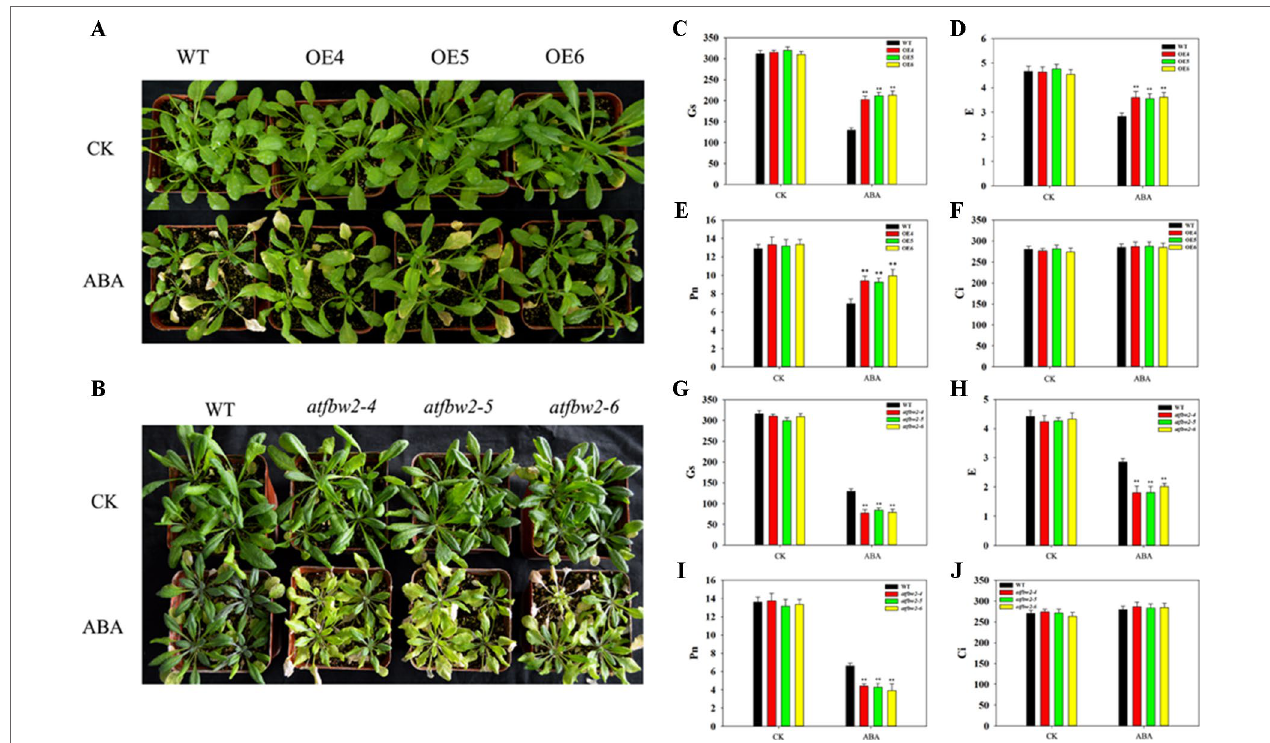
FIGURE 7 | Growth and photosynthetic capacity of Arabidopsis plants after ABA treatment. (A) Phenotype of WT and TaFBA1 -overexpressing plants (OE4, OE5, OE6), (B) WT and mutants ( atfbw2-4 , atfbw2-5, atfbw2-6 ) Arabidopsis lines 10 days after ABA treatment. (C – J) Photosynthetic parameters of Arabidopsis plant leaves after ABA treatment, including (C , G) stomatal conductance (Gs), (D , H) transpiration rate (E) , (E , I) net photosynthetic rate (Pn), and (F , J) intercellular CO 2 concentration (Ci). Data represent mean ± SE of three biological replicates. * P < 0.05; ** P <